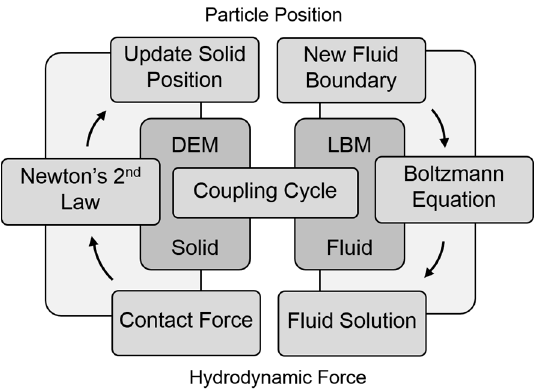
Figure 1. The computation of lattice Boltzmann method (LBM) and discrete element method (DEM) coupling.